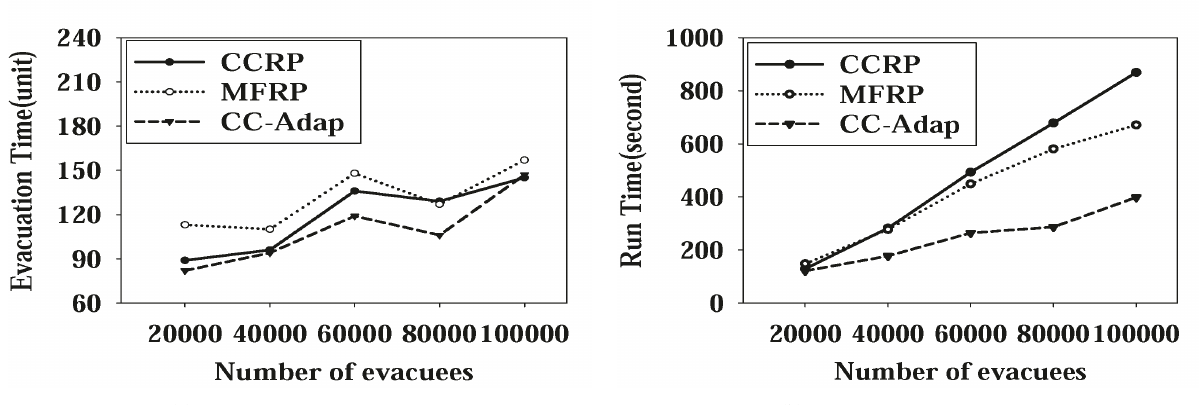
Figure 5: Evacuation quality in a large transportation